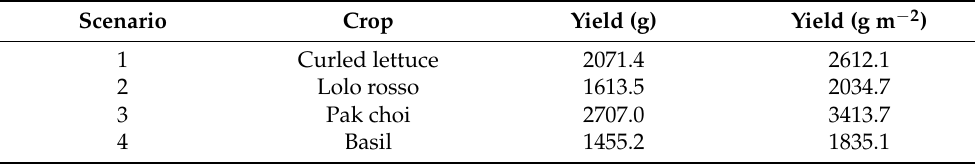
Table 10. Scenario analysis: Calculated productivity of the individual crop.